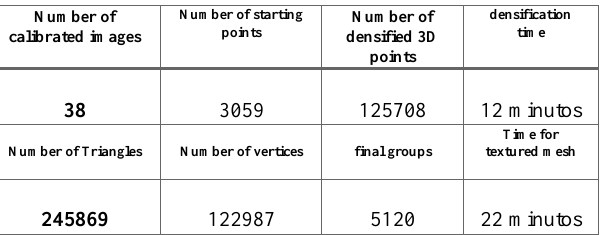
Table 3. Petroglyph quantitative results, videogrammetric method.